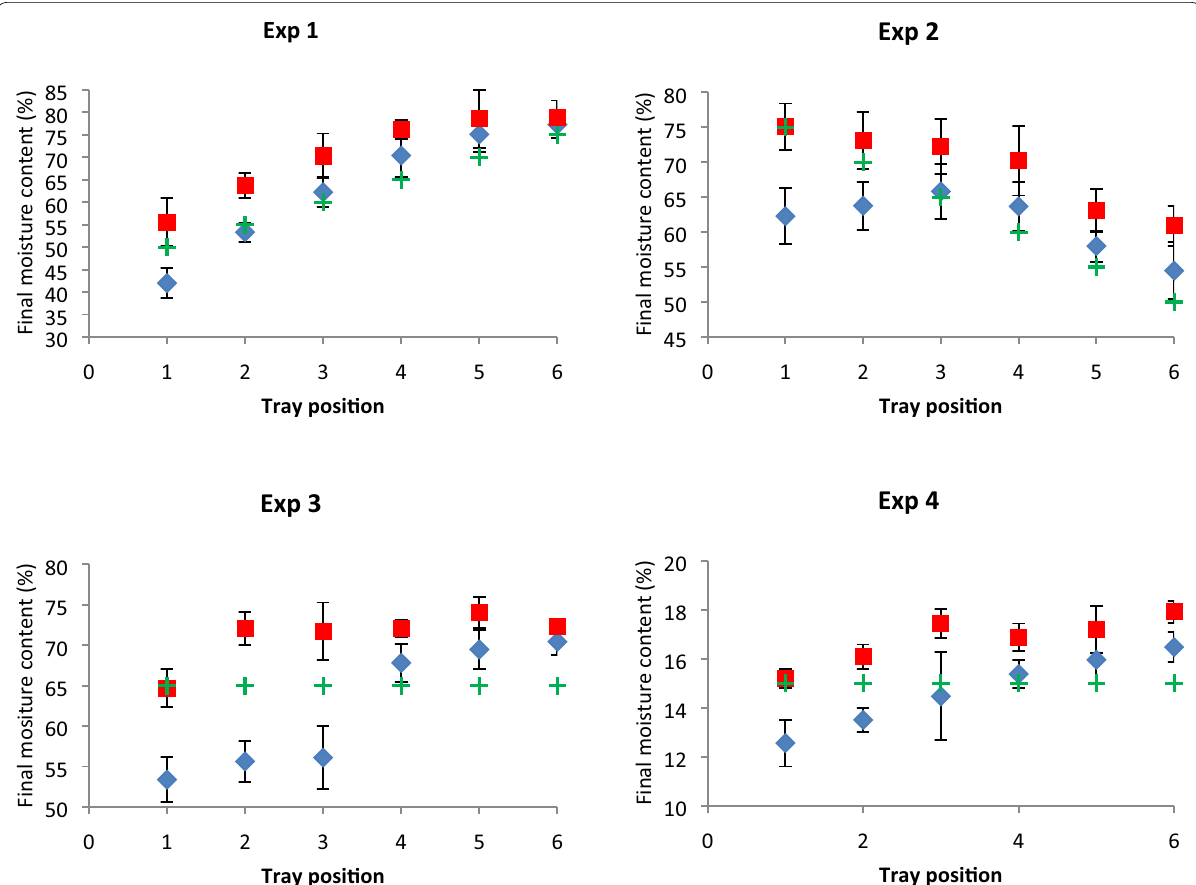
Fig. 3 Profile final moisture content at 72-h fermentation period for different initial moisture content arrangements in multi-stacked circular tray SSB. (plus): initial moisture content in every tray; (filled diamond): A. awamori and (filled square): A. oryzae . The results are shown as mean deviation, and number of replications is three